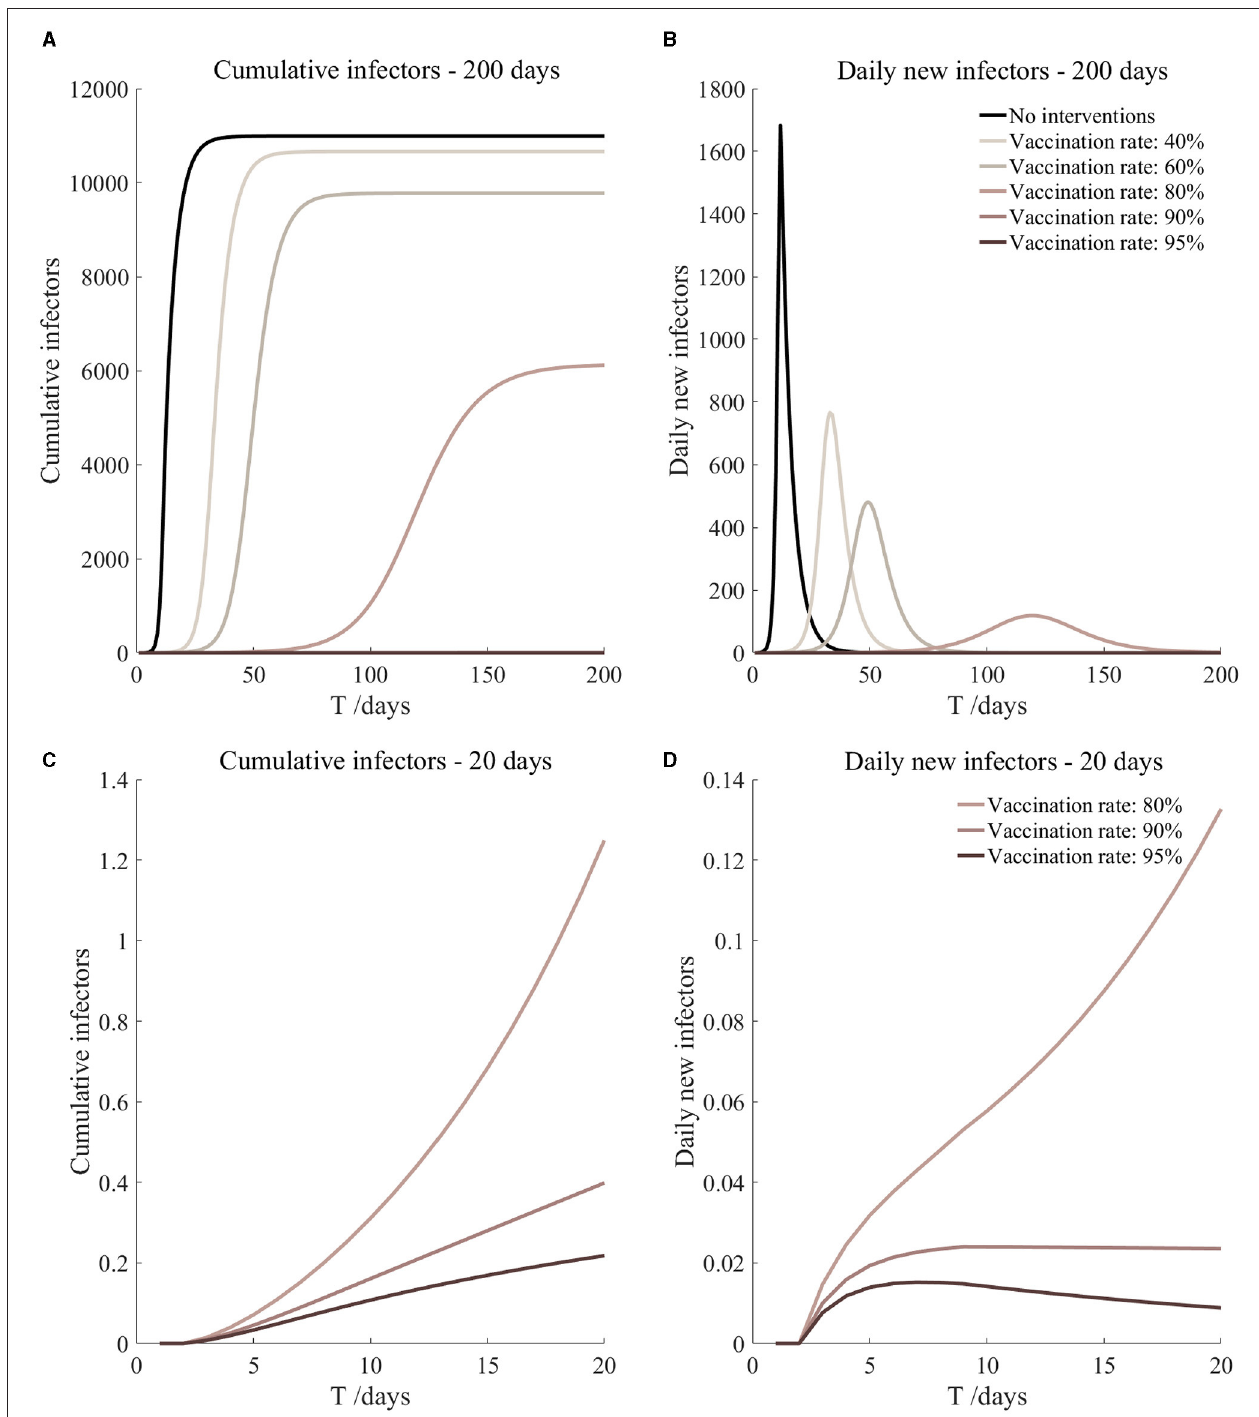
FIGURE 13 | Vaccination and 7-day compulsory quarantine. Assume pre-flight screening can identify 20% of asymptomatic infectors, 7-day compulsory quarantine has about an 18% risk of missed detection.